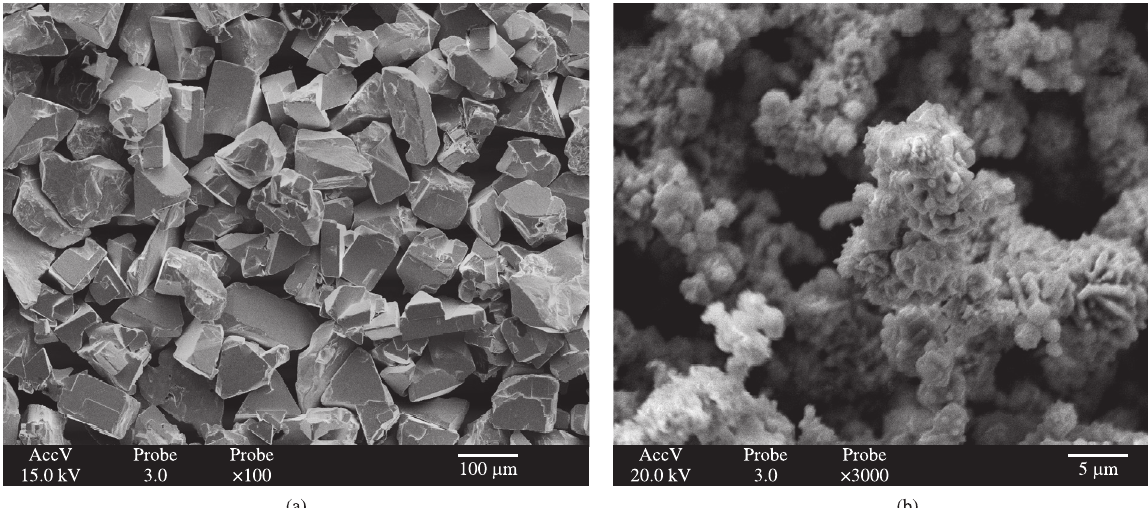
Figure 1. SEM micrographs of the starting powders a) WC and b) Ni.